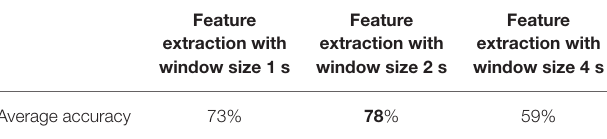
TABLE 1 | The effect of different feature extraction window sizes on the data classification